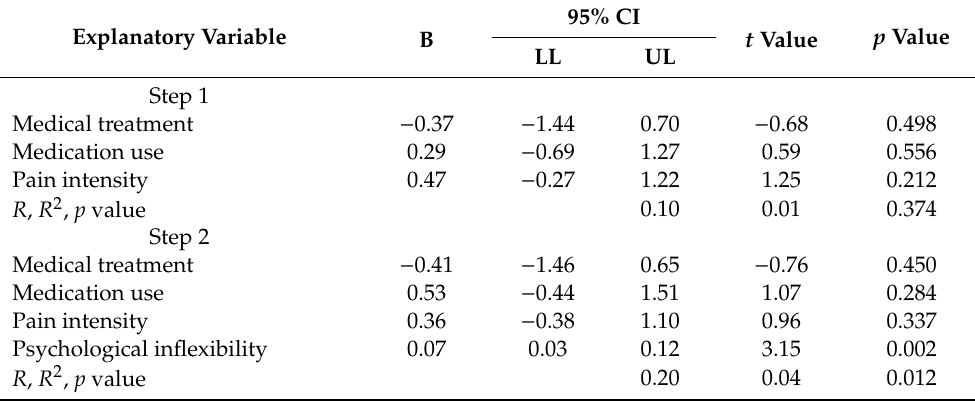
Table 4. Hierarchical multiple regression analysis on daytime sleepiness score with medical treatment, medication use, pain intensity, and psychological inflexibility scores as an explanatory